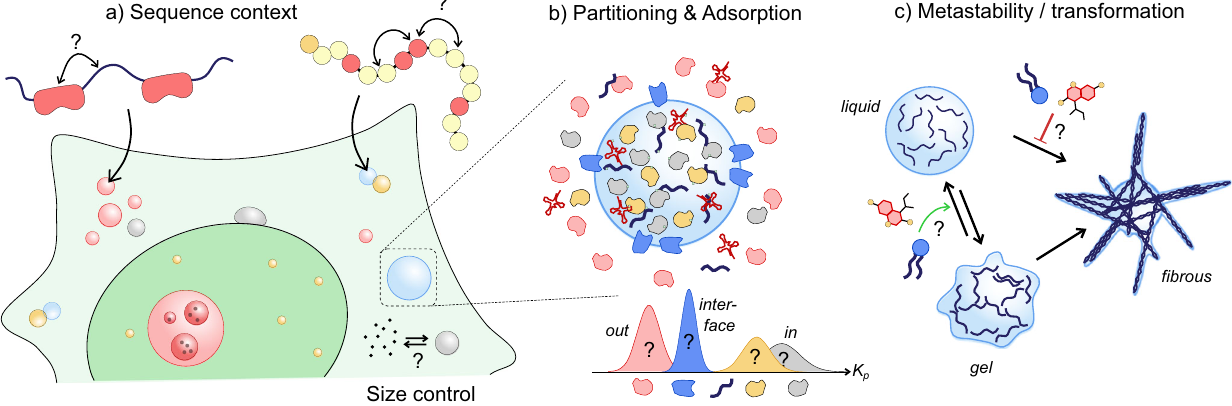
Fig. 2 Open questions on phase-separated droplets in cellular organization. Predicting phase-separating protein sequences is increasingly successful, a the chemical context provided by surrounding amino acids, crowding, and active energy-driven processes are not well understood yet. b The precise composition of condensates and their interfacial structure is often not known, but may have important implications for their function. c Condensates can undergo further transformation into gel-like structures or fi brous aggregates, but the underlying energy landscape and strategies to modulate it remain to be